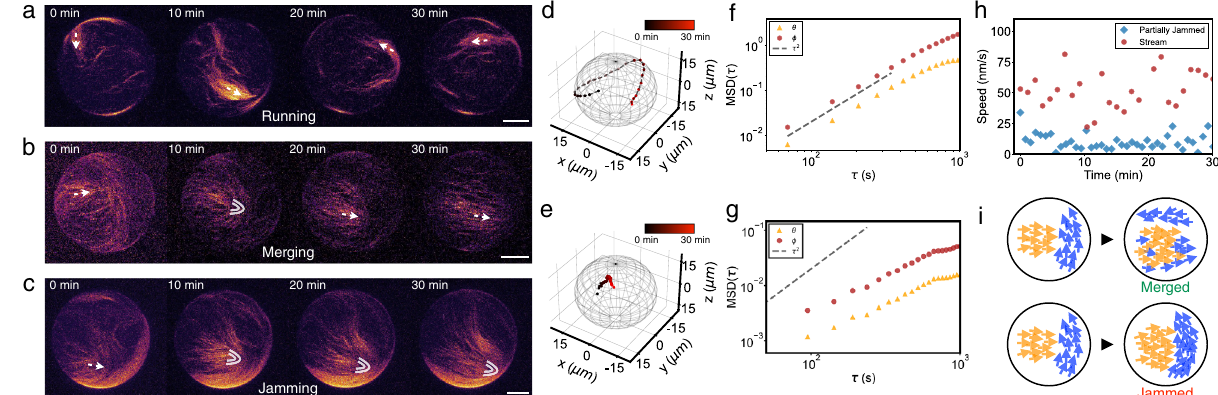
Fig. 3 Stream interaction on an active actin vesicle. a – c Time series (z-projection of confocal stacks) of different individual vesicle displays a stream running at c A = 100 nM ( a ), two streams merging at c A = 150 nM ( b ), and two streams jamming at c A = 300 nM ( c ). Arrows (white) indicate the direction of motion. Parabolic symbols (white) indicate the + 1/2 topological defects. Scale bars, 10 μ m. d Trajectories of the stream from ( a ) moving on a vesicle. e Trajectories of the + 1/2 defect from the partially jammed vesicle ( c ). Time is color-coded; the total time is 30 min. f Mean squared displacement (MSD) of the stream with respect to the polar angles θ (triangle; yellow) and ϕ (circle; red). Dashed line indicates ballistic behavior (MSD ∝ τ 2 ). g MSD of the + 1/ 2 defect in a partially jammed vesicle. Dashed line indicates ballistic behavior. h The instantaneous speed of stream (circle; red) and + 1/2 defect (diamond; blue), shown in ( d ) and ( e ). i Schematics of streams merged (top) and streams jammed (bottom) on the